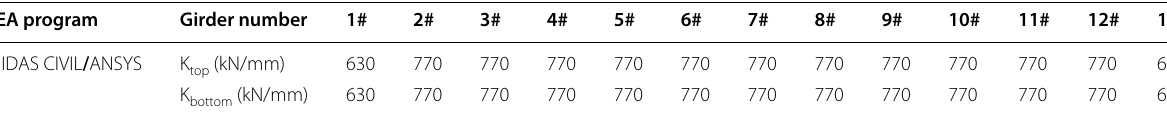
Table 1 Spring coefficients used in FEM. FEA program